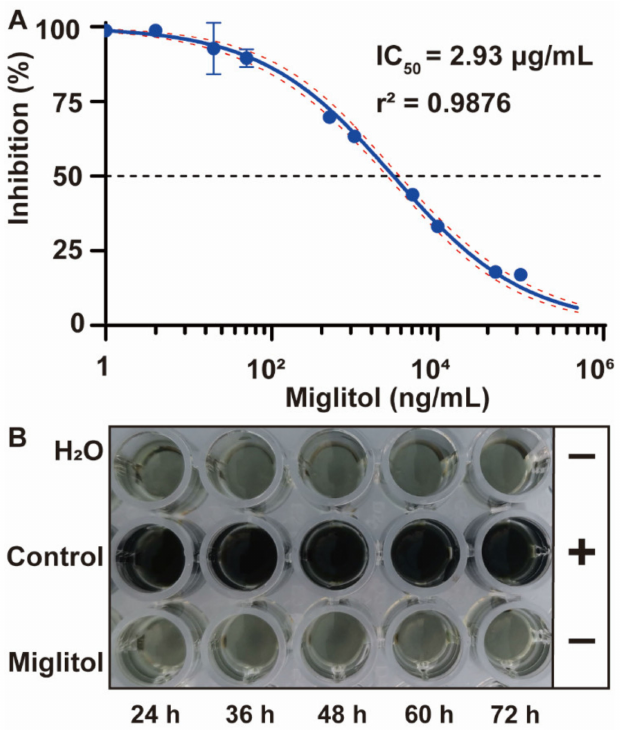
Figure 2. Developing and validating the inhibitory effect of miglitol on β -glucosidase. ( A ) Inhibition of β -glucosidase activity by miglitol at different concentrations. The figures also show the corre- sponding IC 50 values and correlation r 2 values; ( B ) Effect of miglitol on the β -glucosidase activity of T. reesei Rut C30 using 10 g/L MGD as a carbon source and sampled at 24, 36, 48, 60 or 72 h. A quick detection system containing aesculin was employed in 96-well plates with no miglitol or water added as a negative